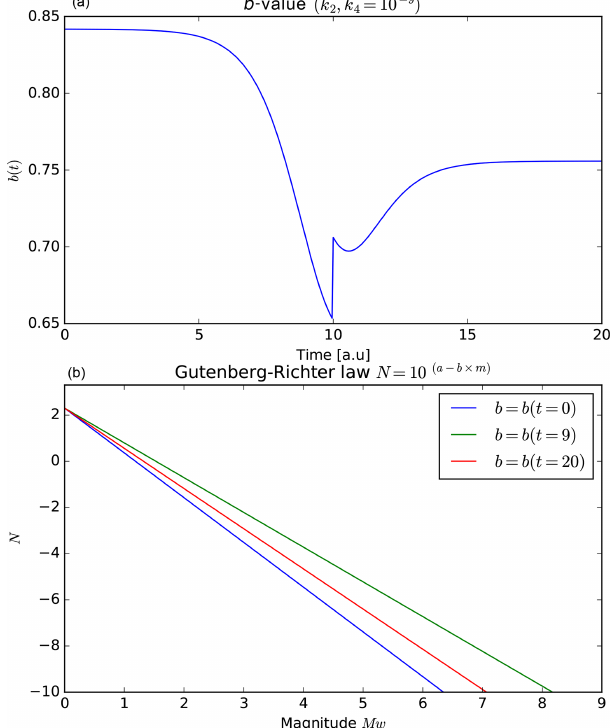
Figure 12. The b -value and Gutenberg–Richter law using k 2 = k 4 = 10 − 10 . The green and red curves are the same.